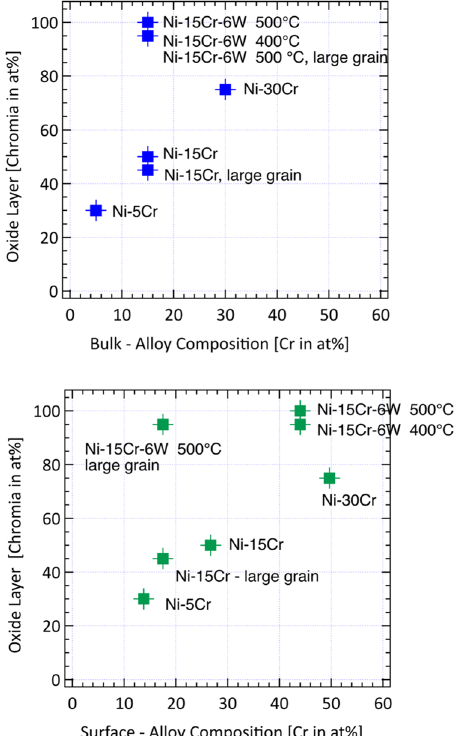
Fig. 7 Cr distribution. Comparison between chromia content in the oxide layer and the bulk and surface composition of the respective alloy. The compositions are calculated from the XPS results, and also included in Figs. 4, 5, Table 1, and Supplementary Information Fig. 9 for the large grain sample. For the chromia content in the oxide the largest value observed within each oxidation sequence is used. The error bar is ± 4% for the chromia contribution to the oxide (ordinate), and ± 2% for the Cr contribution in the alloy (abscissa).